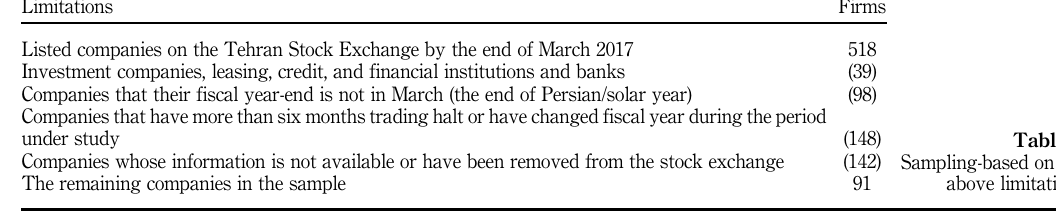
Table I. Sampling-based on the